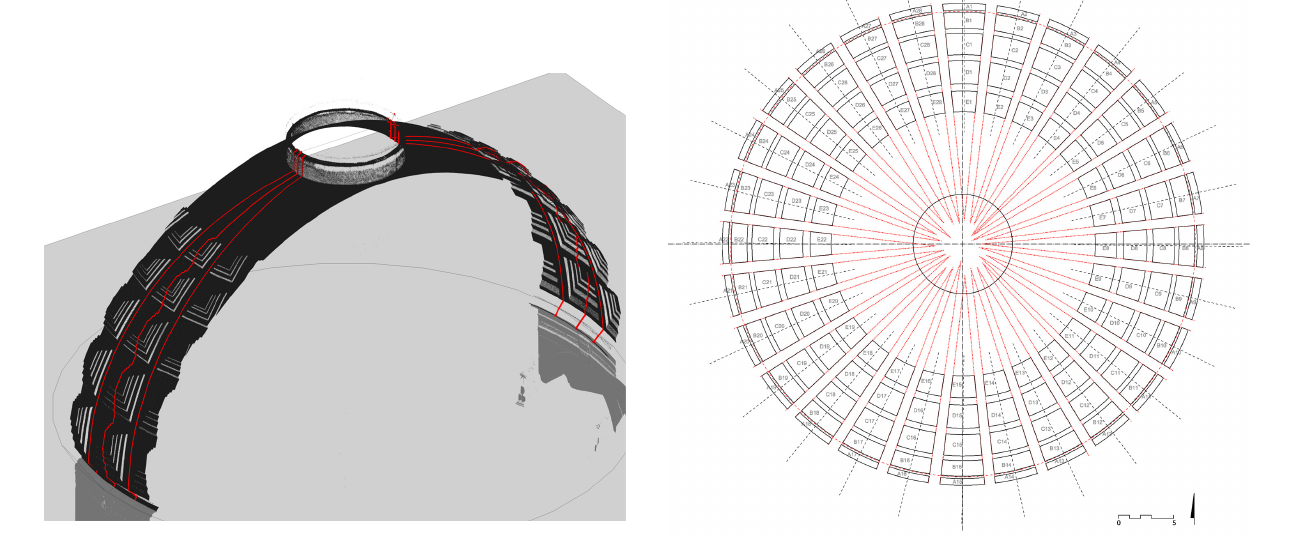
Figure 8. Meridian sections taken directly from the point cloud Figure 9. Alignments of the coffers' external edges showing that they don't converge in the center of the oculus